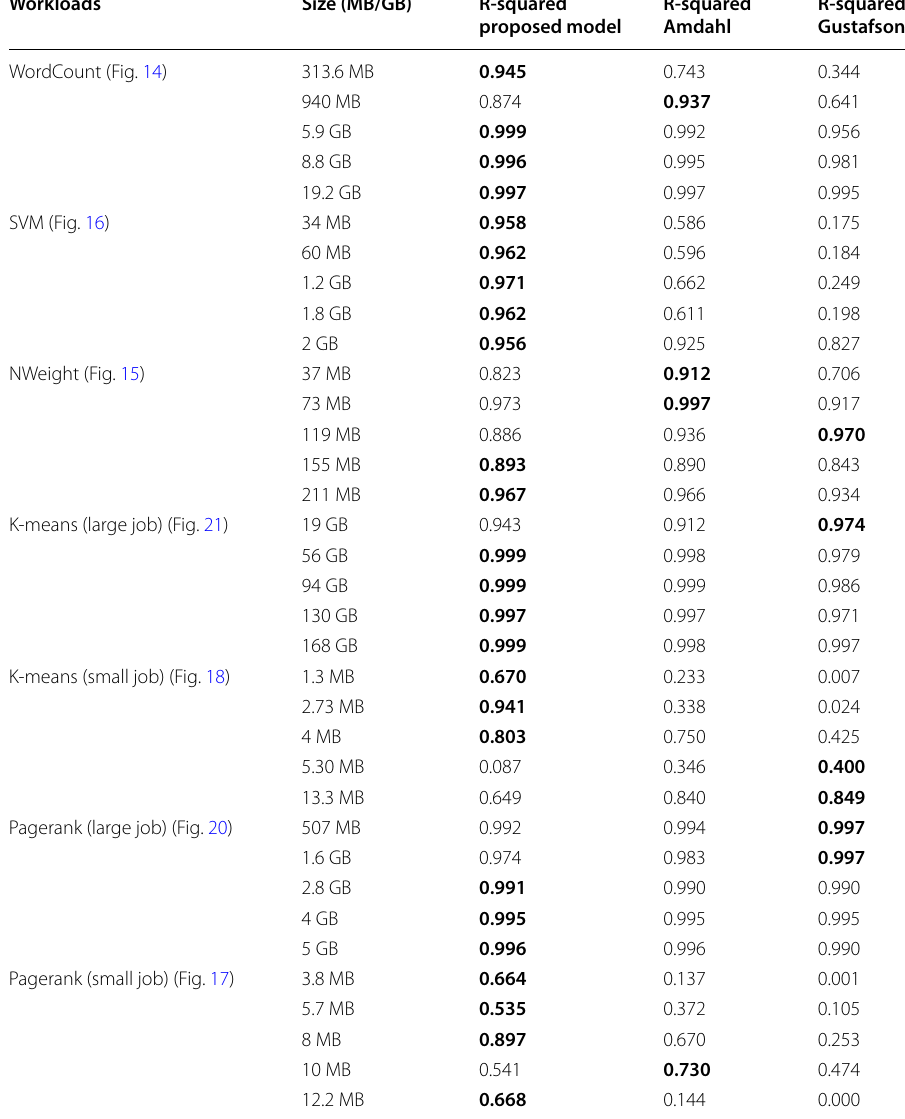
Table 6 R-squared estimates for all the workloads